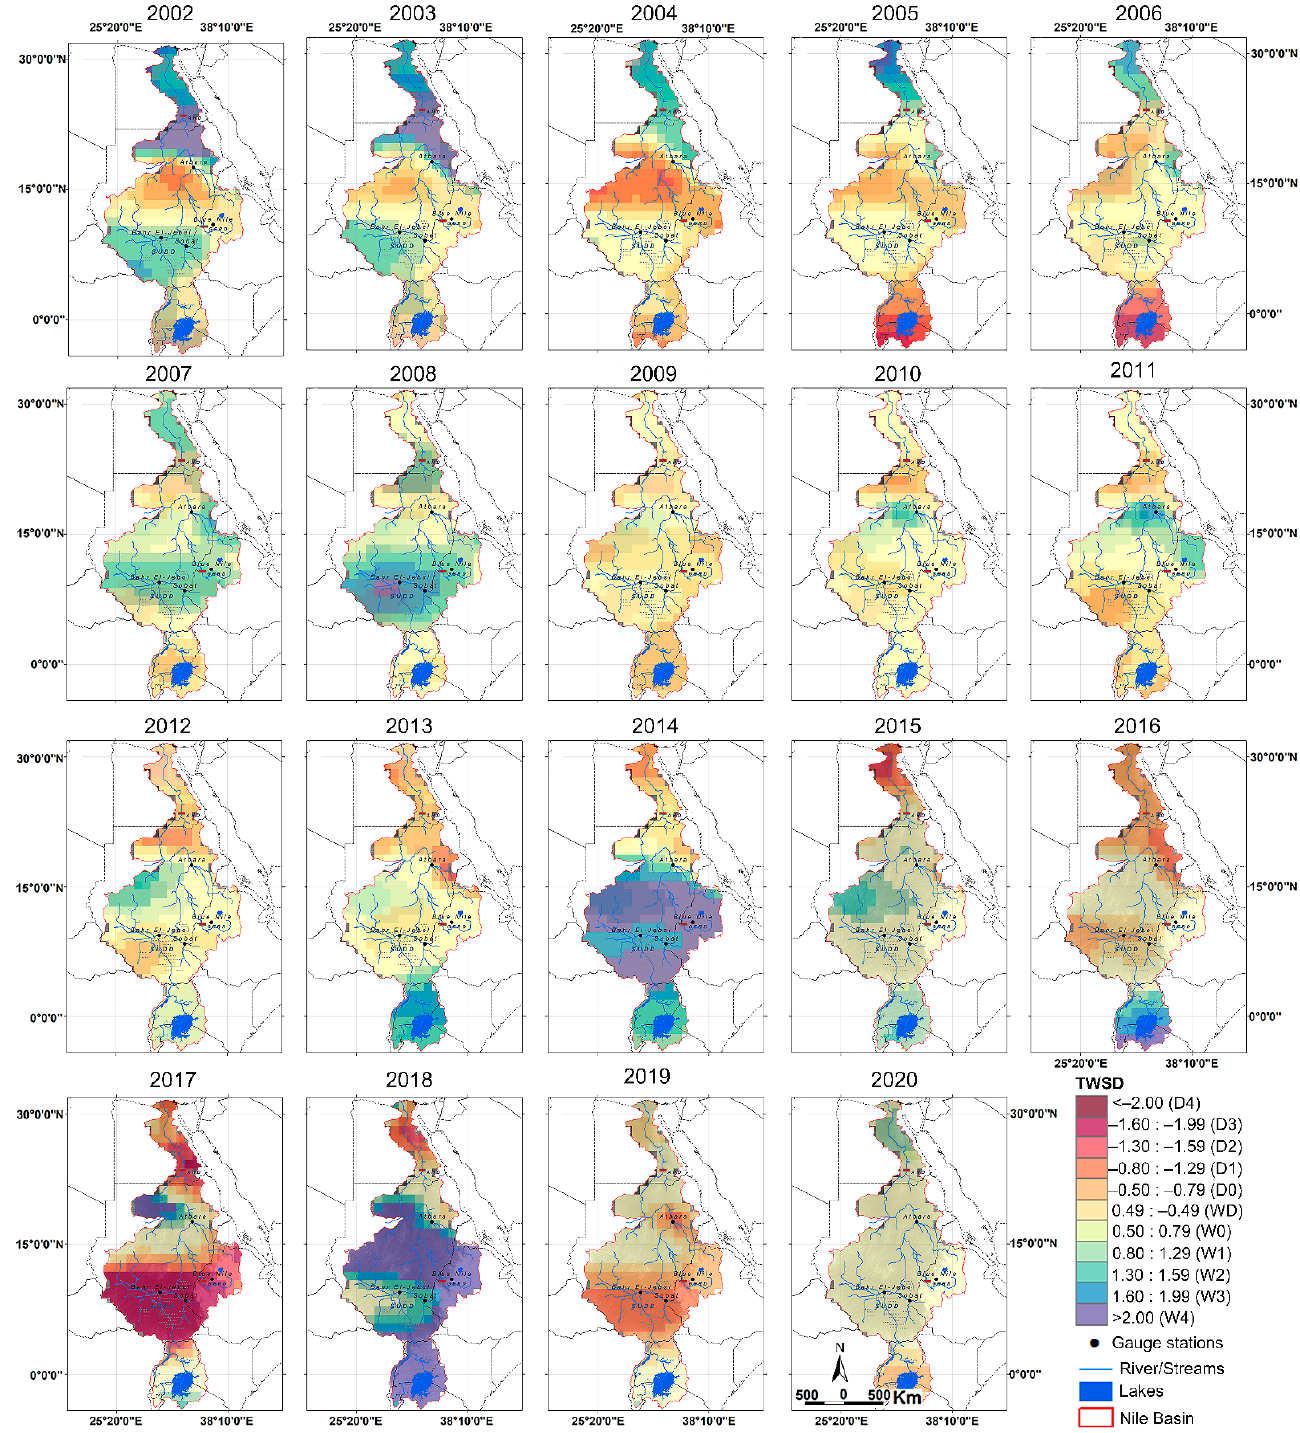
Figure 11. The spatial pattern of the TWSD over the NRB between 2002 to 2020. Other regions across the basin showed remarkable dryness and wetness records between 2002 to 2020. The western portion of the White Nile at the Bahr El Jabel area, for instance, exhibited moderate to very wet conditions during the years of 2002, 2003, 2007, and the year 2008. The years 2014 and 2018 showed extreme wet conditions. The Bahr El Jabel region demonstrated normal conditions for the period between 2004 to 2006, and the years of 2009, 2010, 2013, and 2020. In the years 2017 and 2019, the Bahr El Jabel region recorded extreme dry conditions to moderately dry conditions, respectively. The